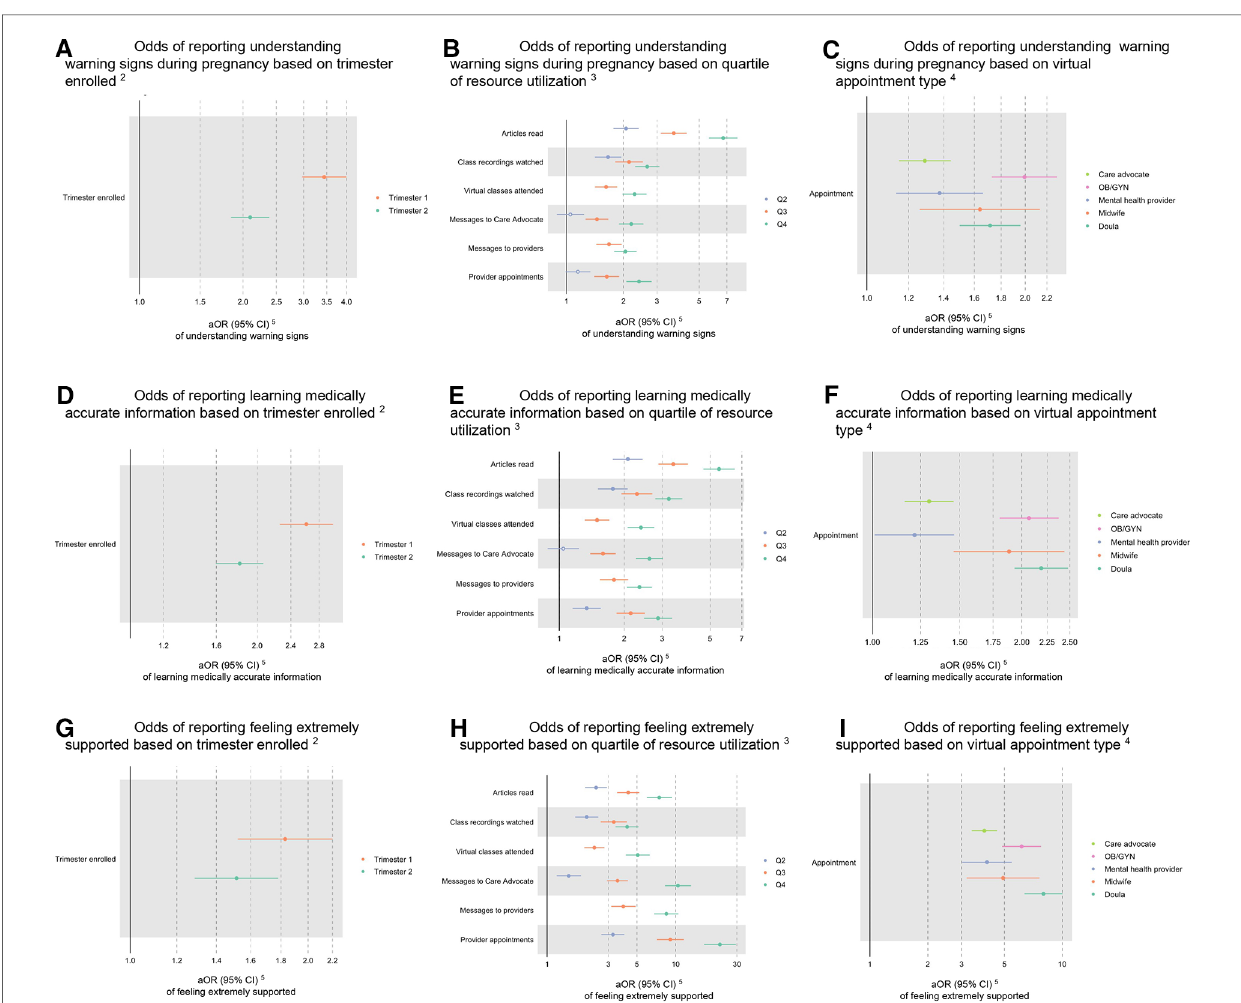
FIGURE 4 Effectofutilizationonunderstandingwarningsignsinpregnancy,learningmedicallyaccurateinformationaboutpregnancy,andfeelingsupportedintotalsample 1 . ( A ) Odds of reporting understanding warning signs during pregnancy based on trimester enrolled 2 . ( B ) Odds of reporting understanding warning signs during pregnancy based on quartile of resource utilization 3 . ( C ) Odds of reporting understanding warning signs during pregnancy based on virtual appointment type 4 . ( D ) Odds of reporting learning medically accurate informationbased ontrimesterenrolled 2 . ( E ) Odds of reporting learning medically accurate informationbased on quartile of resource utilization 3 . ( F ) Odds of reporting learning medically accurate information based on virtual appointment type 4 . ( G ) Odds of reporting feeling extremely supported based on trimester enrolled 2 . ( H ) Odds of reporting feeling extremely supported based on quartile of resource utilization 3 . ( I ) Odds of reporting feeling extremely supported based on virtual appointment type 4 . 1 Filled data points represent statistically signi fi cant fi ndings ( p <0.05), and un fi lled data points represent fi ndings that are not statistically signi fi cant. 2 Compared to Trimester 3 enrollment. 3 Compared to Quartile 1 utilization. 4 Compared to userswho did not have an appointment with each provider type. 5 Adjusted odds ratio (95% con fi dence